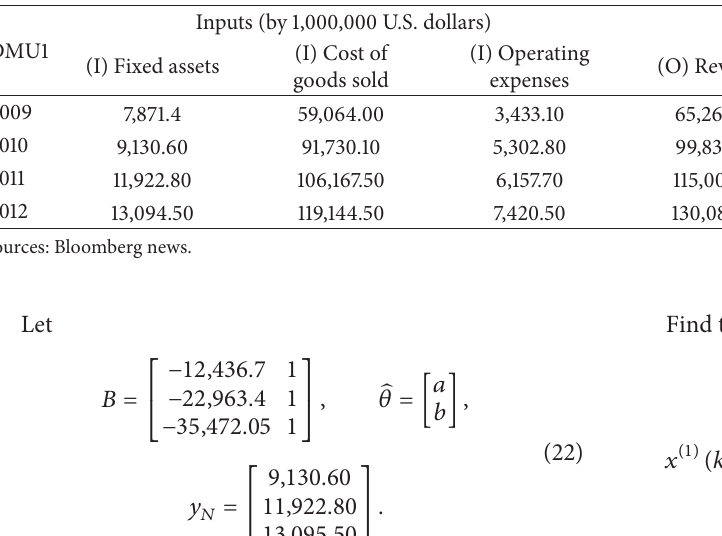
Table 3: Inputs and outputs factors of DMU1 in period of